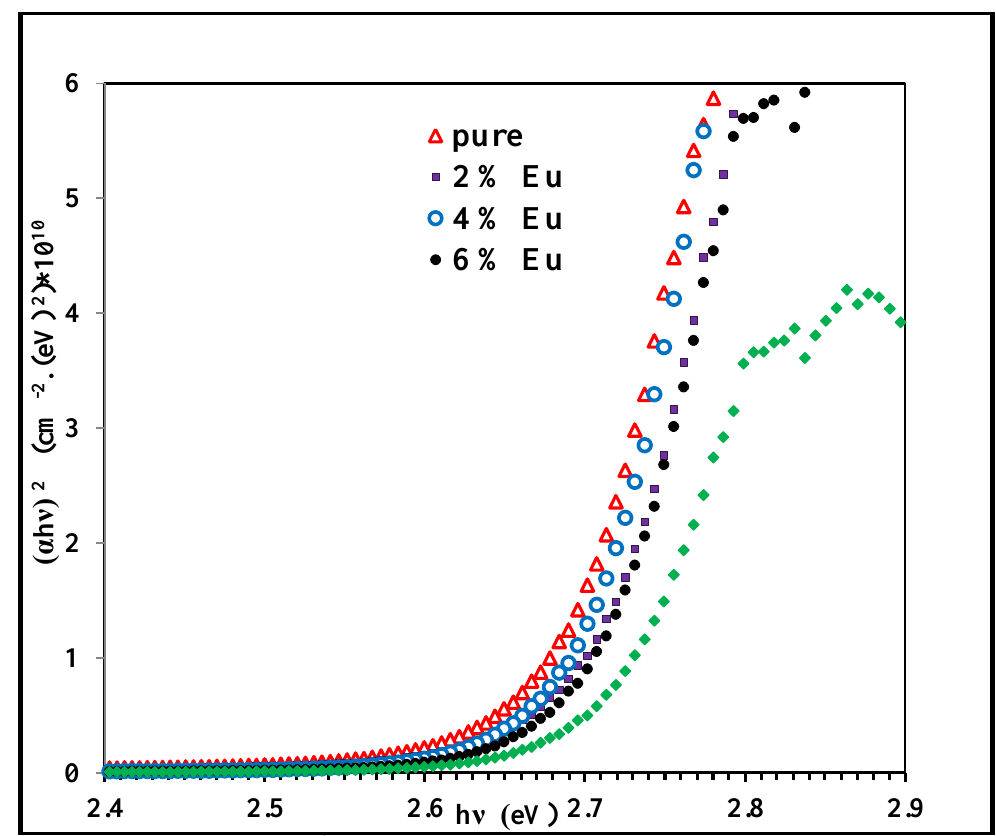
Fig.5: The variation of (αhυ) 2 versus photon energy (hυ) for V and 8) wt %. Eu